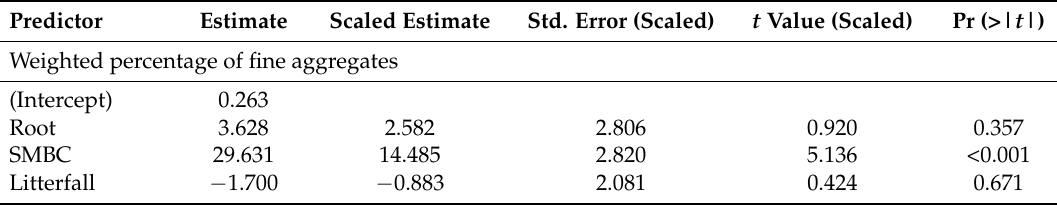
Figure 5. The relationships between soil resident water-stable macroaggregates, soil organic carbon, fine-root biomass, and soil microbial biomass carbon in the topsoil (0–10 cm) of poplar plantations. Top, middle, and bottom rows are fine aggregates, large aggregates, and SOC of bulk soil in relation to annual litterfall production ( a , b & c ), fine-root biomass ( d , e & f ), and microbial biomass carbon ( g , h & i ) sampled in June, August, and October, respectively. R 2 values are <0.1 for regressions in a , b and c ; 0.717 (June), 0.681 (August), and 0.726 (October) for regressions in d ; 0.720 (June), 0.871 (August), and 0.926 (October) for regressions in e ; 0.864 (June), 0.752 (August), and 0.879 (October) for regressions in f ; 0.876 (June), 0.355 (August), and 0.668 (October) for regressions in g ; 0.562 (June), 0.014 (August), and 0.848 (October) for regressions in h ; 0.442 (June), 0 (August), and 0.780 (October) for regressions in i . The coefficient of determination and significance of fitted regressions are shown as p values and their corresponding 95% confidence intervals are shaded. Table 4. The results of ridge regression, which related annual litterfall production, fine-root biomass, and soil microbial biomass to weighted percentages of fine and large aggregates and soil organic carbon content in bulk soil ( n = 3).